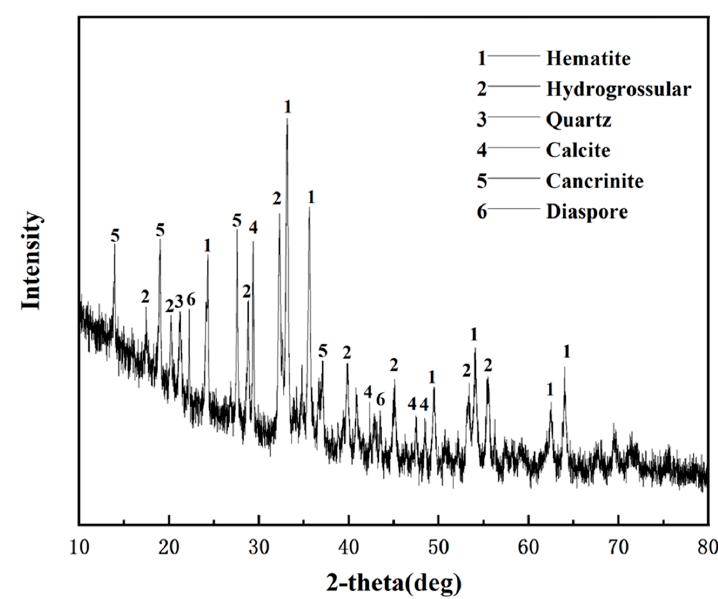
Figure 2. XRD pa tt ern of the red mud sample. Figure 2. XRD pattern of the red mud